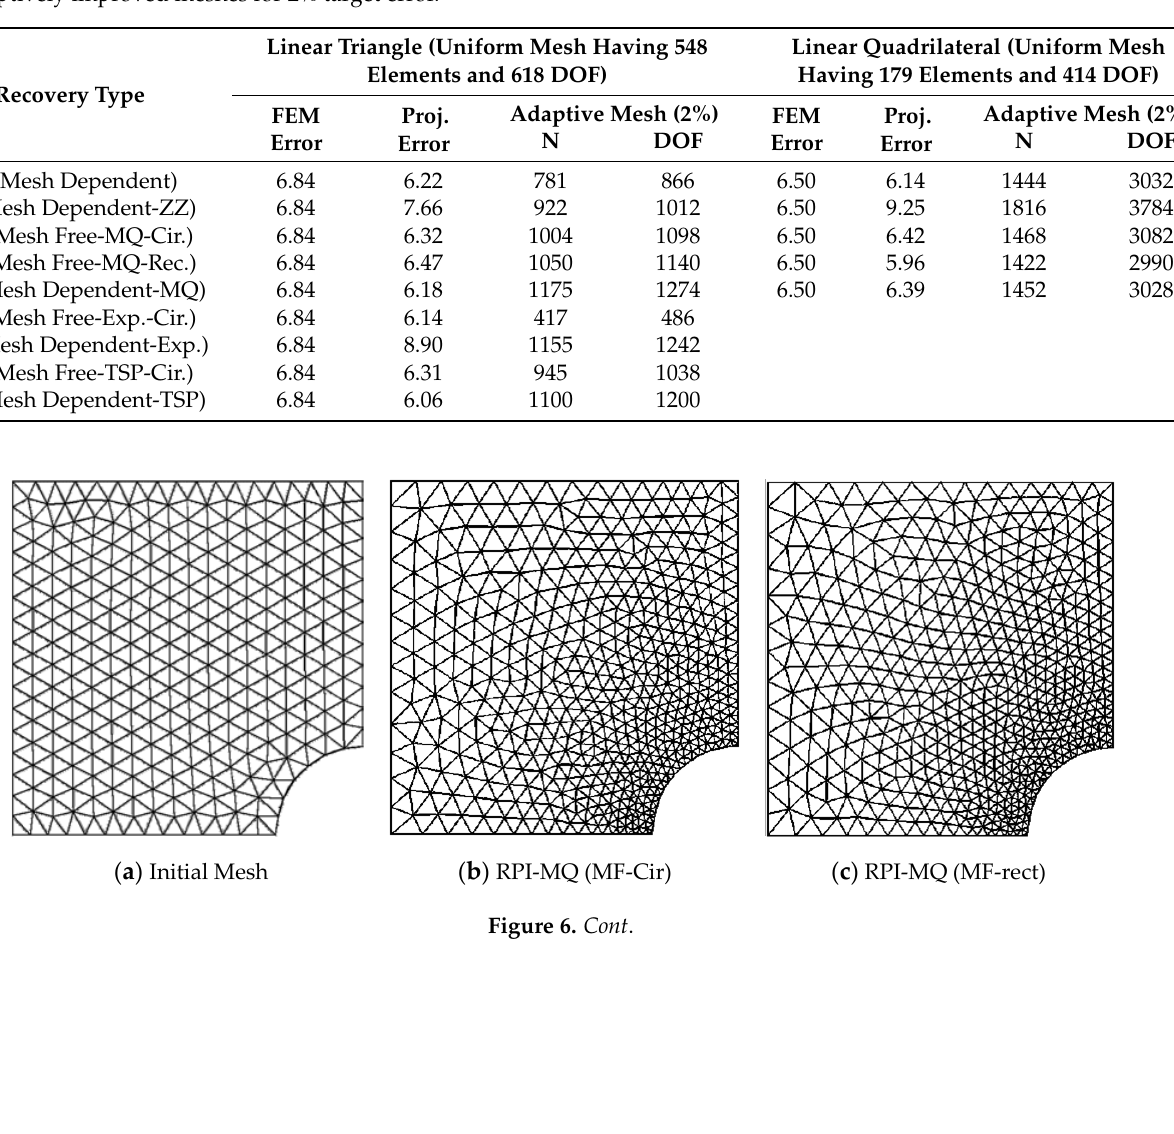
Table 14. Global errors using various recovery-based finite element analysis and number of elements (N) with DOF in adaptively improved meshes for 2% target error.